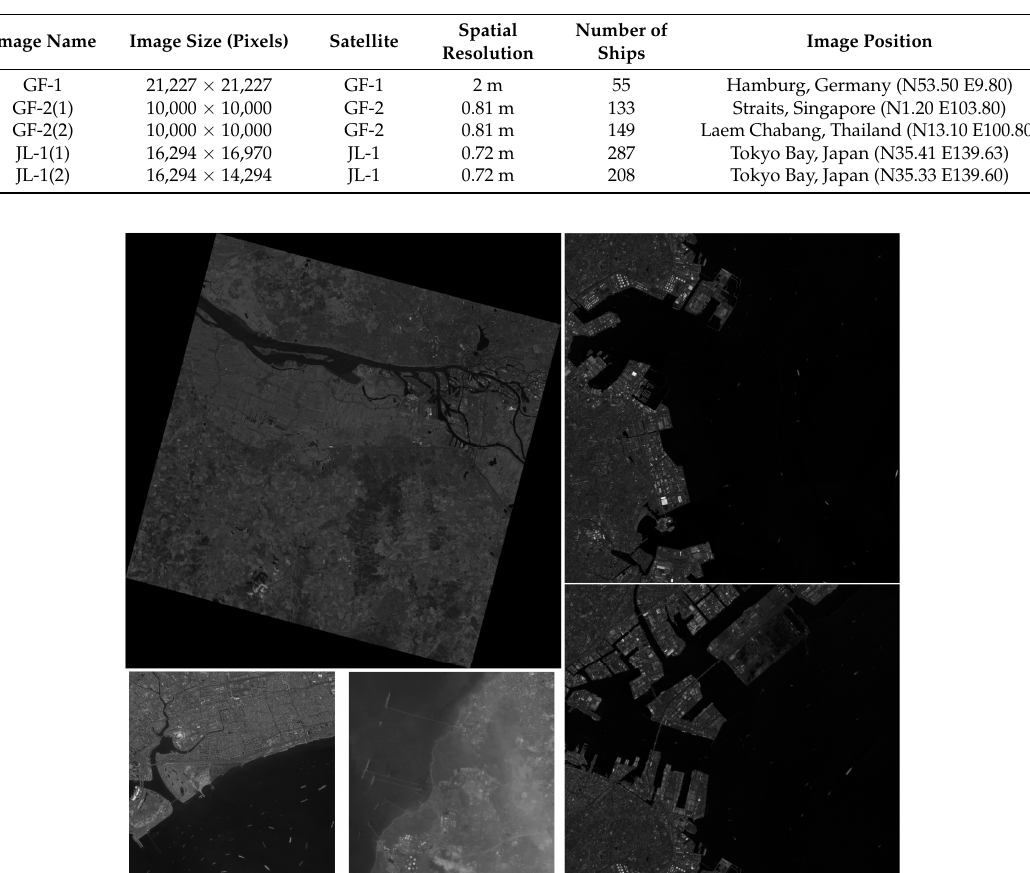
Table 4. Information of five large images.